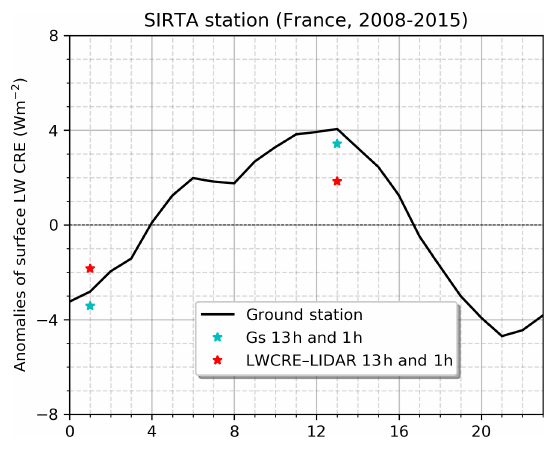
Figure 11. Same as Fig. 9b but in the anomaly of diurnal cycles over